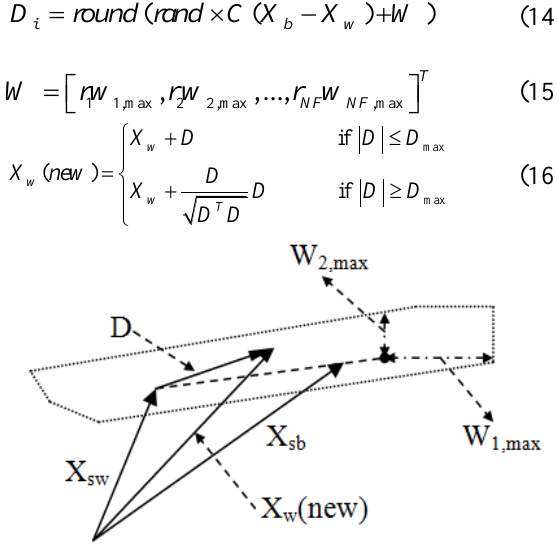
Figure 5. The modification of the frog leaping rule .